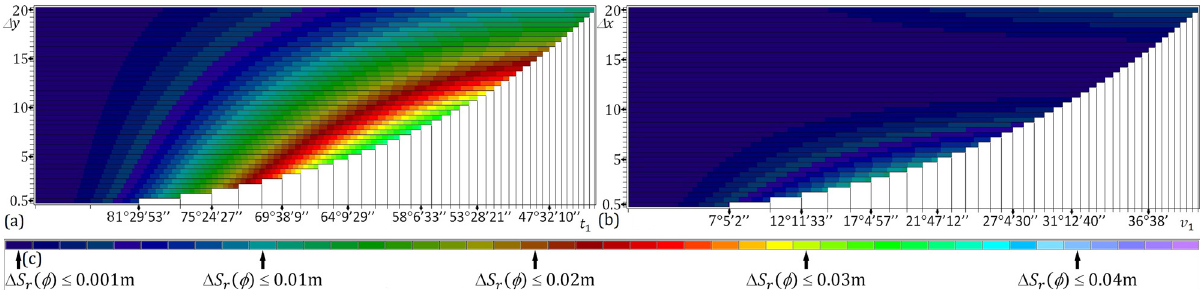
Figure 8: The depth of the fi rst row in the stands: ( a ) BAI, BBI ( for y Δ 0.5, 1, 1.5, 2, …,20 { } ∈ ) , ( b ) AAI, ABI ( for x Δ 0.5, 1, 1.5, 2, …,20 { } ∈ ) , and ( c ) color